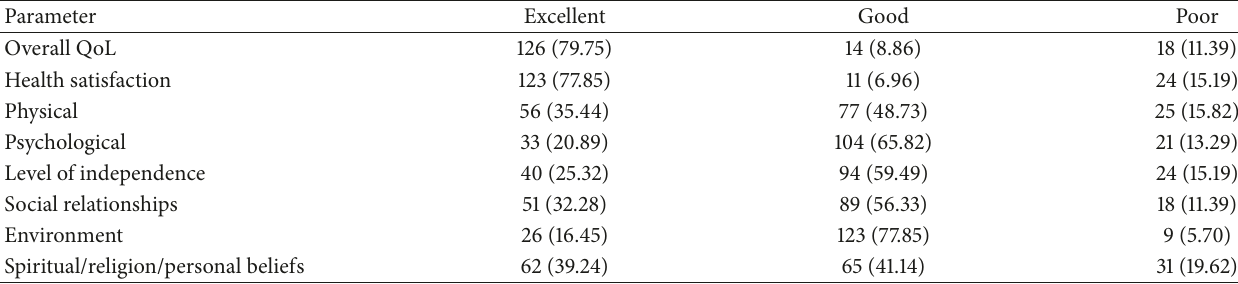
Table 3: Components of the quality of life of people living with HIV/AIDS in the Ho municipality.